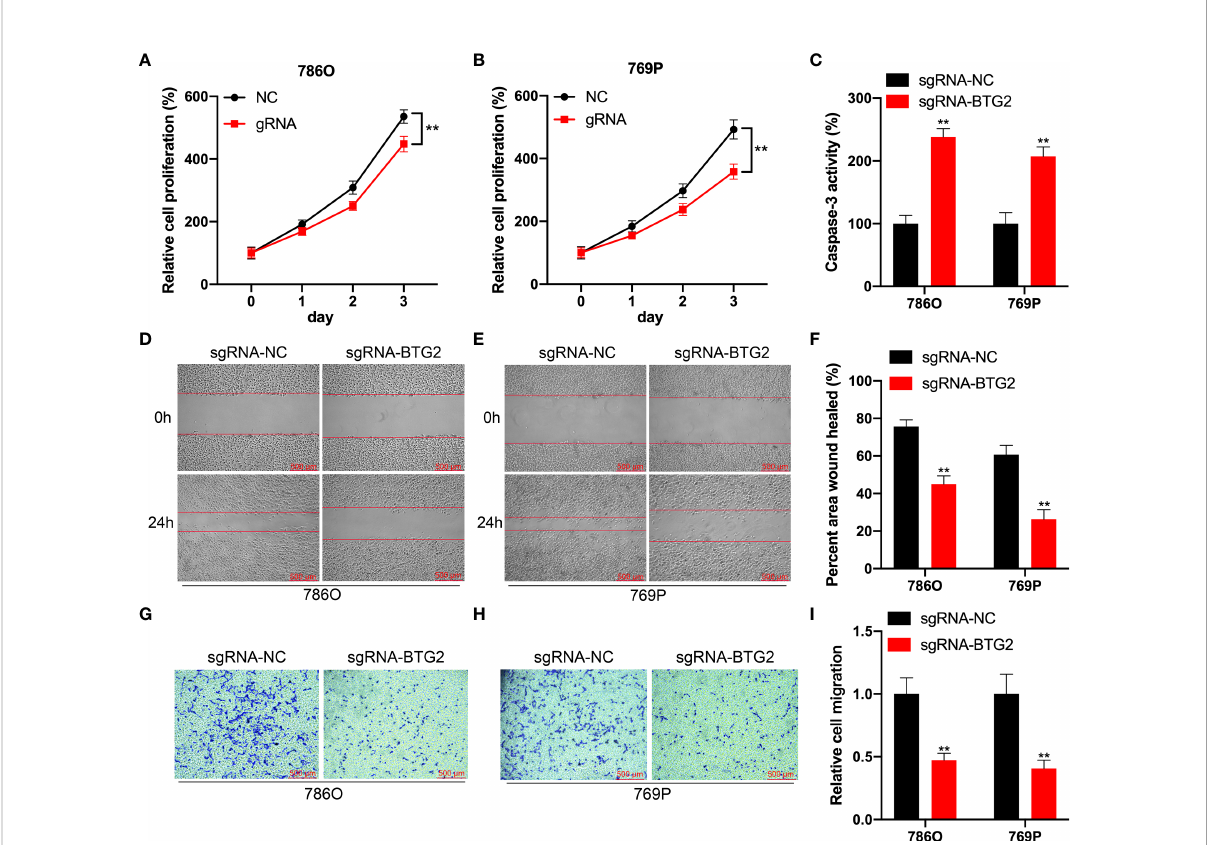
FIGURE 6 Speci fi cal m 6 A methylation of BTG2 inhibits RCC cells proliferation and promotes cell apoptosis by CRISPR/dCas13b-METTL3. (A, B) . The cell proliferation of 786O (A) and 769P (B) cells transfected with dCas13b-M3 combined with gRNA control or gRNA for BTG2 was detected by CCK8 assay. (C) The cell apoptosis of 786O (A) and 769P (B) cells transfected with dCas13b-M3 combined with gRNA control or gRNA for BTG2. (D-F) Wound-healing assays for migration ability of 786O (D) and 769P (E) cells after transfected with dCas13b-M3 combined with gRNA control or gRNA for BTG2. (G-I) . Transwell assays for migration ability of 786O (D) and 769P (E) cells after transfected with dCas13b-M3 combined with gRNA control or gRNA for BTG2. **